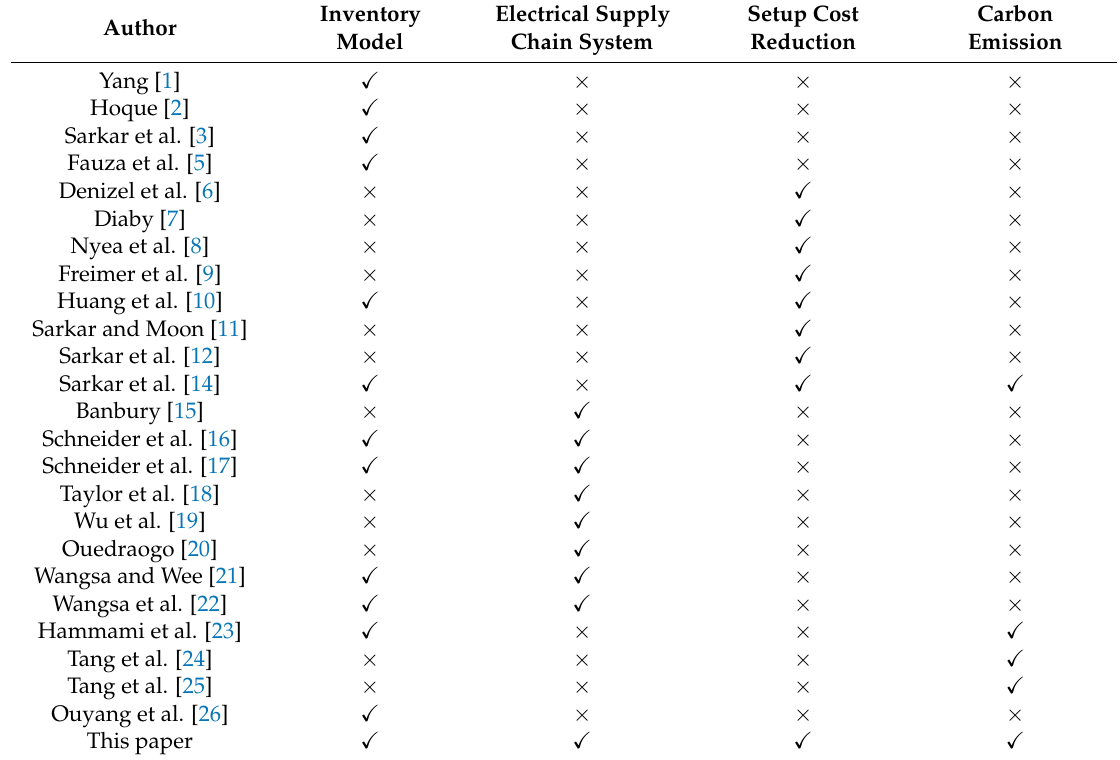
Table 1. Other authors contribution to this